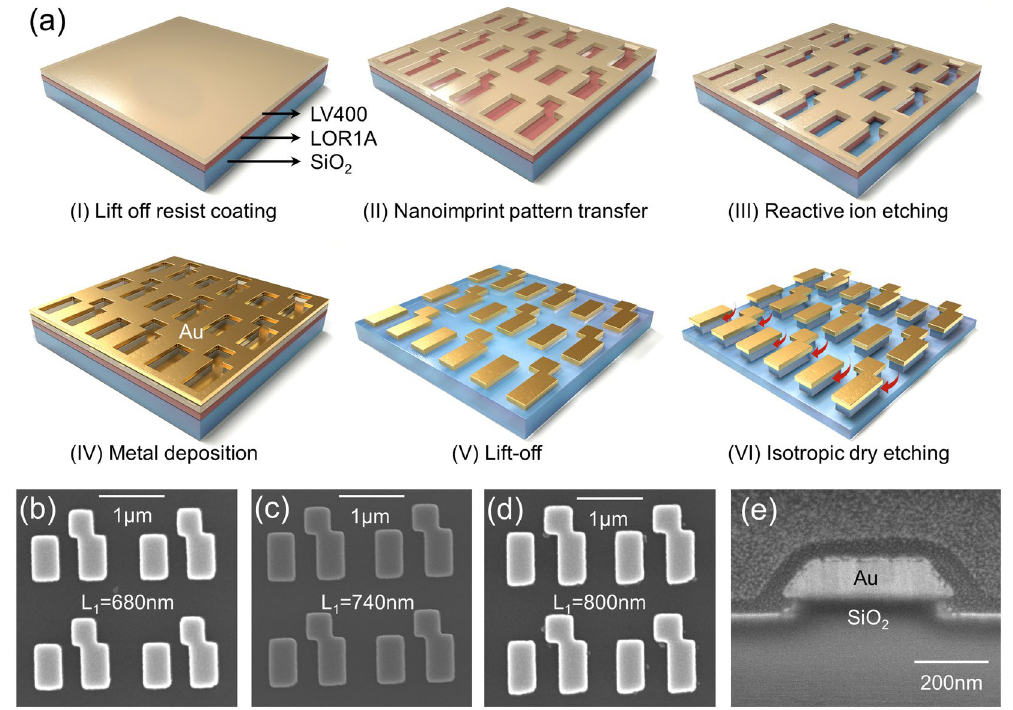
Figure 3. ( a ) Device fabrication process. SEM images of the fabricated FMM on the nanopedestal with ( b )